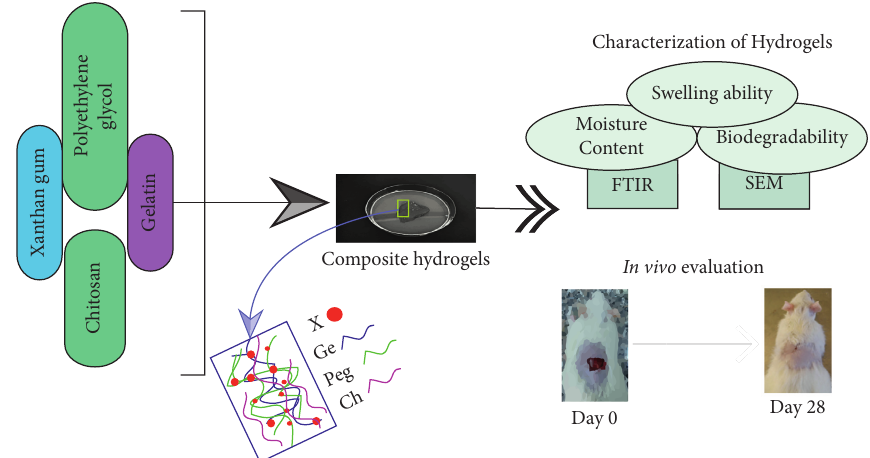
Figure 1: An overview of the present research.